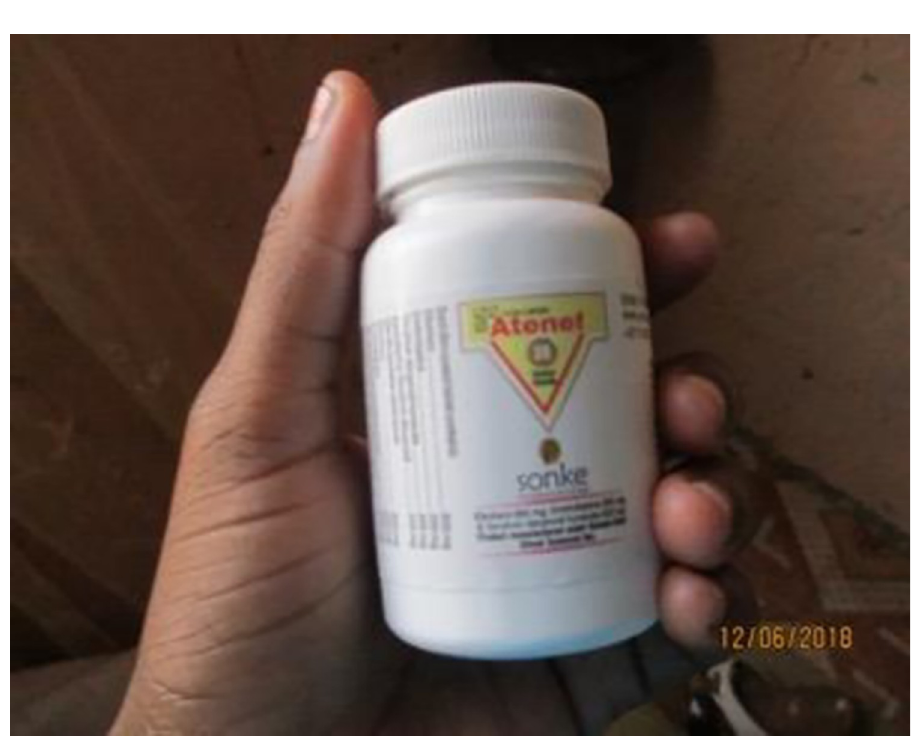
Fig 6. Image from co researcher 34–18.